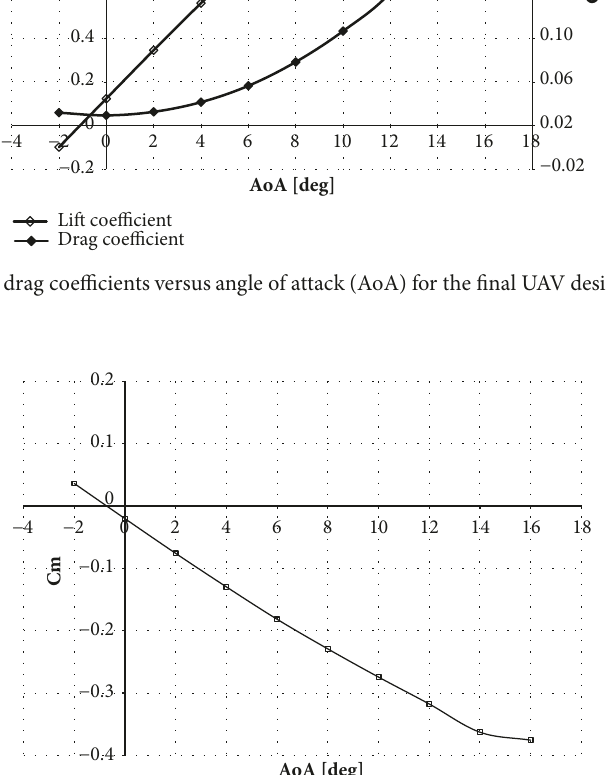
Figure 10: Pitching moment coefficient versus AoA for the final UAV design (Re = 237 000).